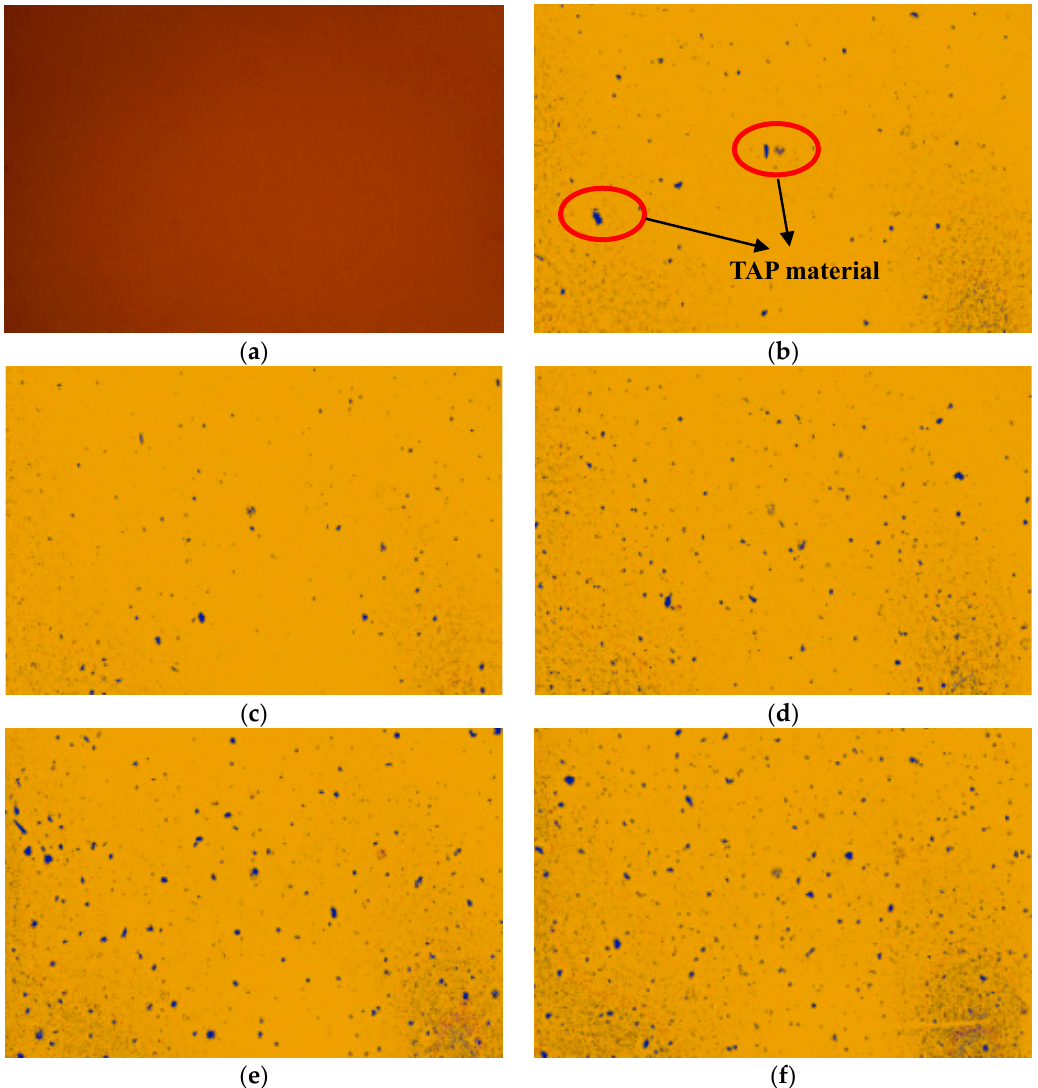
Figure 4. Morphological results: ( a ) base asphalt, ( b ) 5%, ( c ) 10%, ( d ) 15%, ( e ) 20%, and ( f ) 25%.